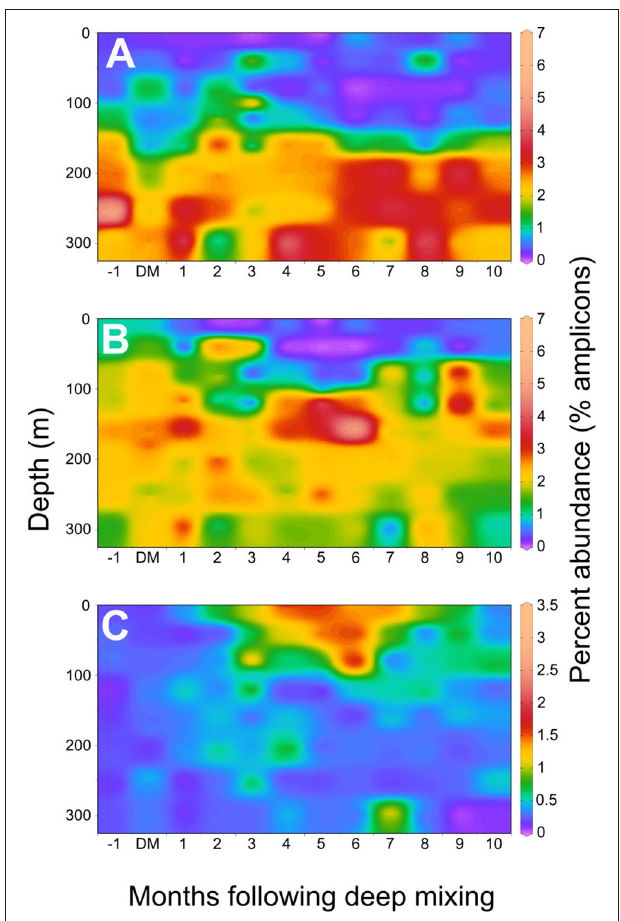
FIGURE 4 | Seasonal distributions of SAG taxa in the western Sargasso Sea. An annual composite of 16S rRNA amplicon data from a BATS 10-year time series were used to plot variation in the upper 300 meters at BATS (data from Vergin 2017; Giovannoni and Vergin, 2012; Vergin et al., 2013). X-axis represents month-relative timing of maximal deep mixing (DM) in each year of the time series record, as previously reported. (A) E01-9C-26 marine Gammaproteobacteria (B) . Sva0996 marine Acidimicrobiales, (C) Verrucomicrobia node 1938, corresponding to the Opi.OSU.00C